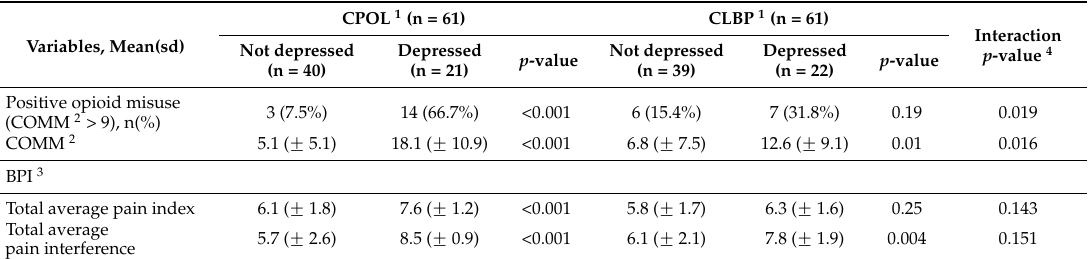
Table 2. Distribution of patient opioid misuse risk and pain characteristics by depression, stratified by pain location (n =